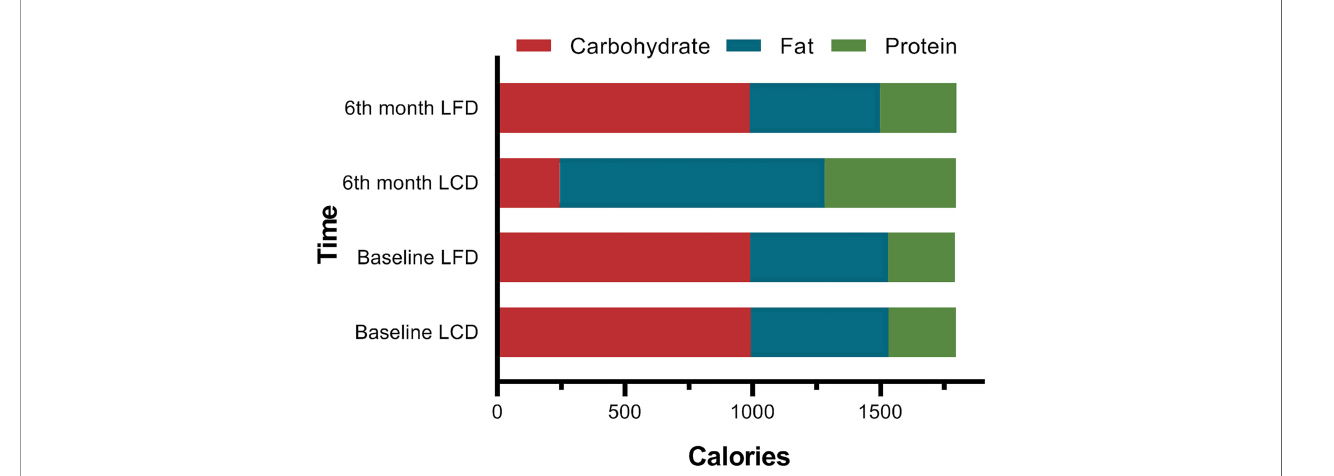
FIGURE 2 | Comparison of the Calories from Three Macronutrients. At baseline, there were no signi fi cant differences between the two groups. The percentage of the calories from carbohydrates (13.61%) met the standard of LCD (<14%) in the LCD group, while the 28.38% calories from fat met the standard of